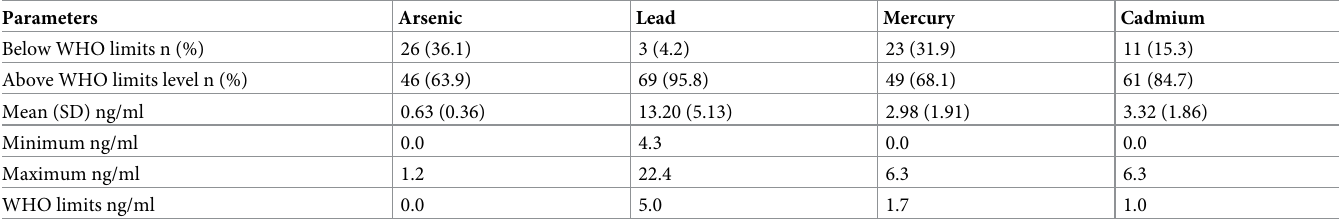
Table 2. Concentration of toxic heavy metals in the breast milk of the diabetic group N = 72.